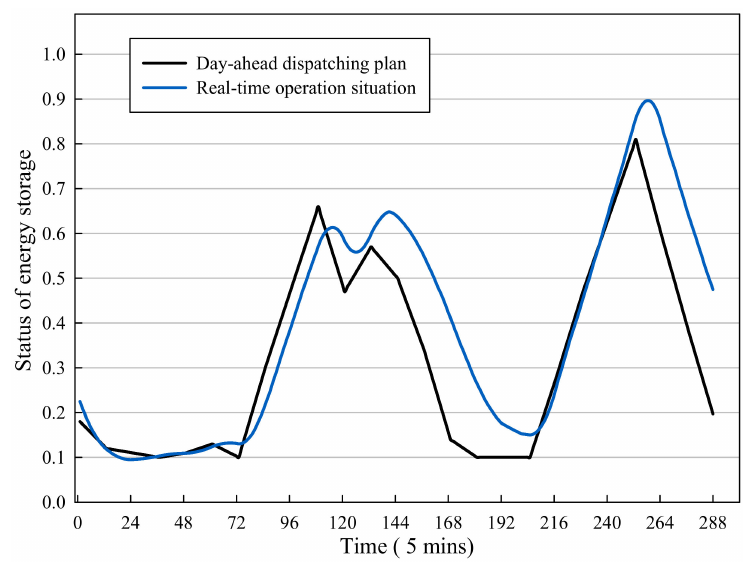
Figure 15. Comparison of operating status of cold energy storage equipment under real-time and day-ahead dispatching strategy.